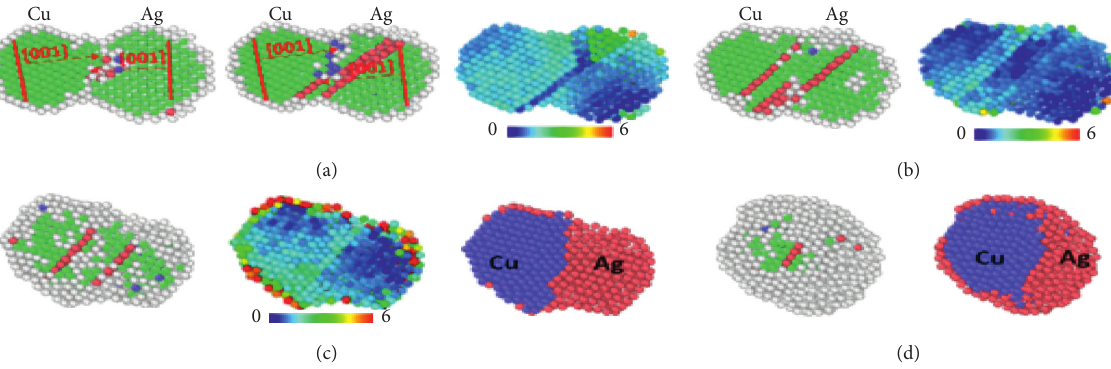
Figure 3: Cross section of sample at AA’, BB’, CC’ and D steps in Figure 2. (Green atoms, red atoms, white atoms are FCC structure, HCP structure, disorder structure,